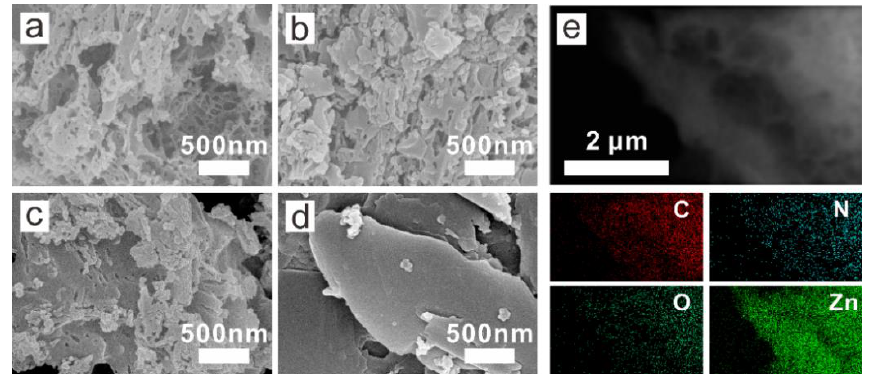
Figure 2. SEM images of ( a ) C 3 N 4 Zn 0.32 O 0.51 , ( b ) C 3 N 4 Zn 0.61 O 0.61 , ( c ) C 3 N 4 Zn 1.10 O 1.02 and ( d ) C 3 N 4 Zn 1.52 O 1.30 ; ( e ) EDS mapping of C 3 N 4 Zn 1.10 O 1.02 .